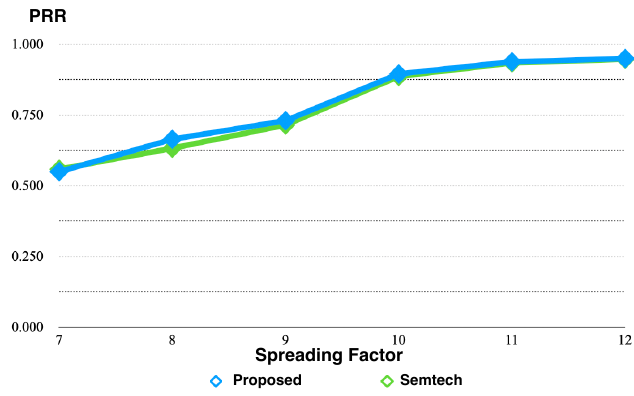
Figure 11. PRR vs. SF in B2